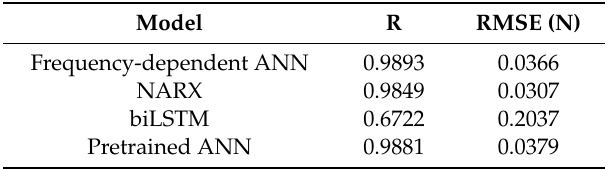
Figure 10. Regression plots of the predictions for the academic case with 6 sensors: ( a ) frequency- dependent ANN, ( b ) NARX, ( c ) ANN with biLSTM layer, and ( d ) pretrained ANN. Table 3. Regression coefficients and RMSE for the different models.